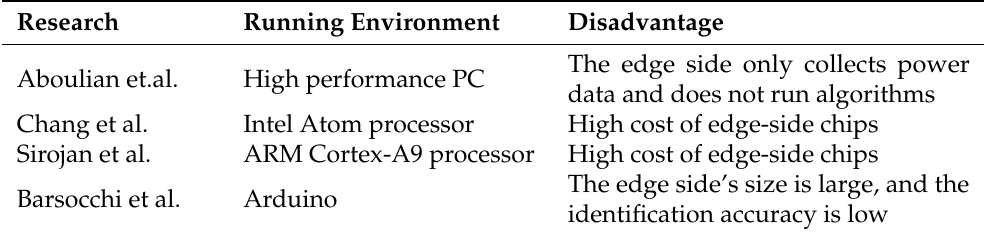
Table 1. Disadvantages of existing